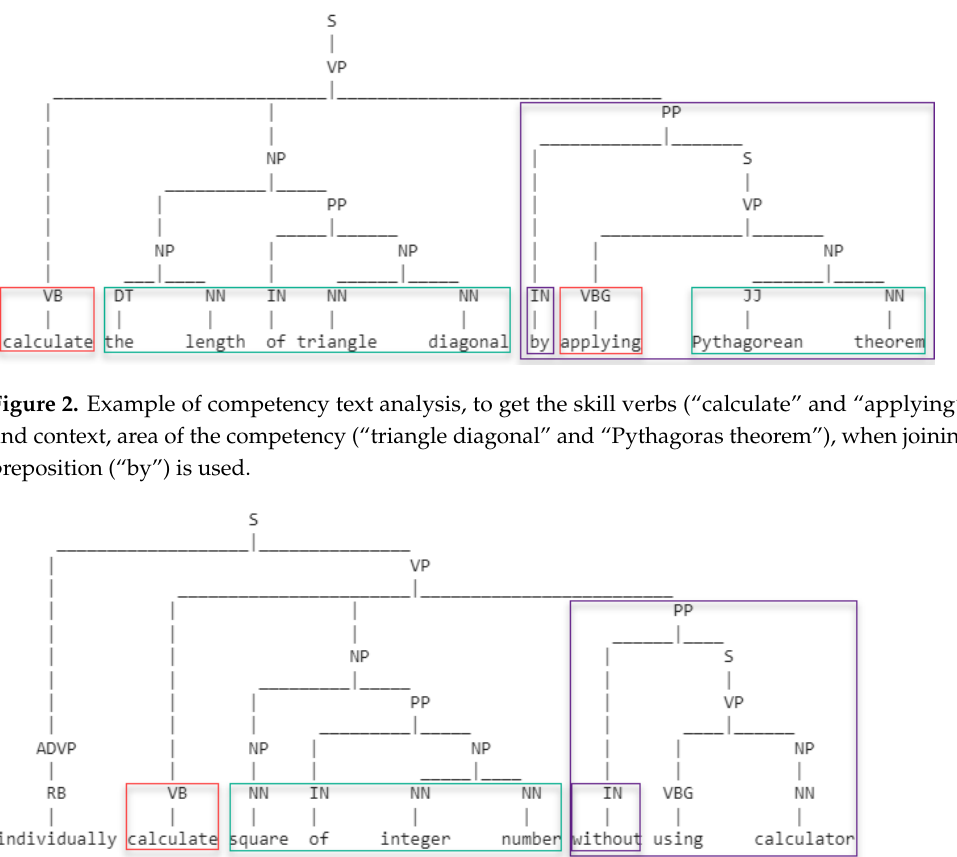
Figure 3. Example of competency text analysis, to get the skill verbs (“calculate”) and context, area of the competency (“square” and “integer number”), when not joining preposition (“without”) is used.